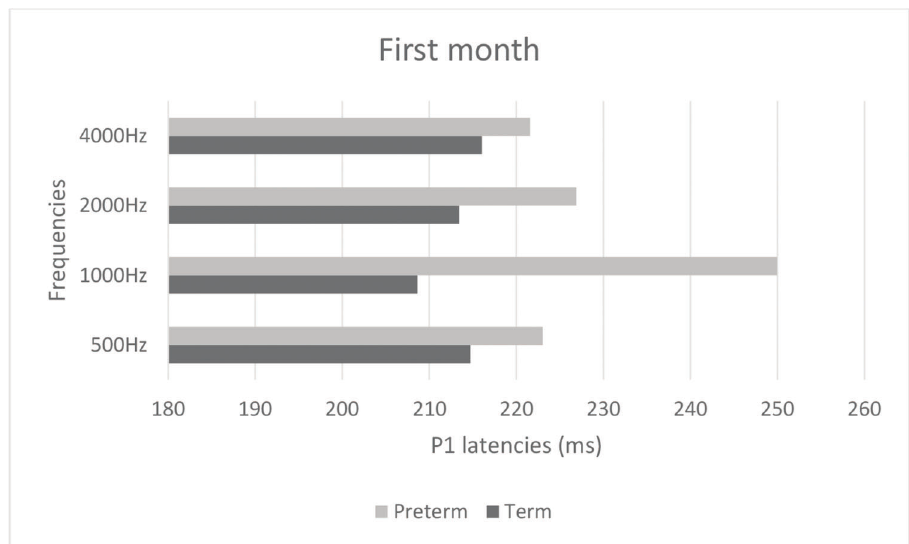
Figure 2 - P1 latency values in term and preterm infants in the first month of life.